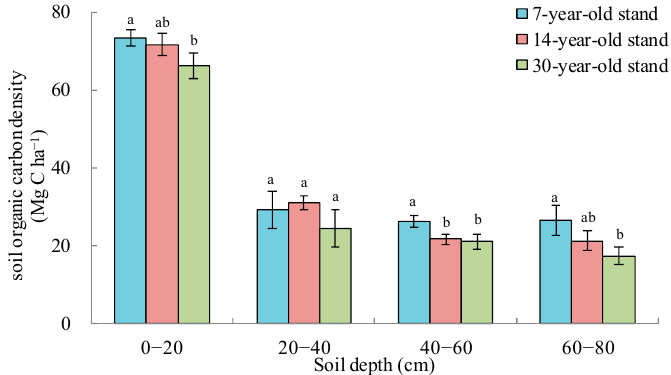
Figure 5. Variability in SOC density across a chronosequence of Masson pine plantations.